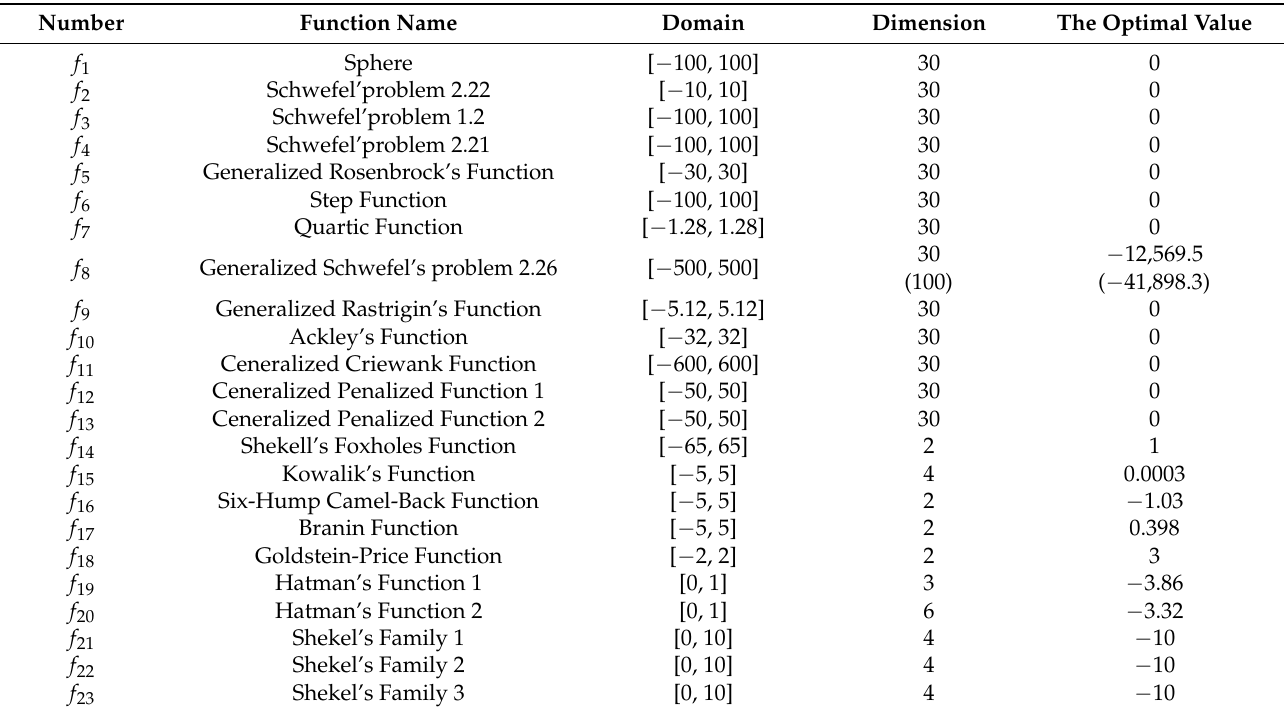
Table 2. Benchmark function